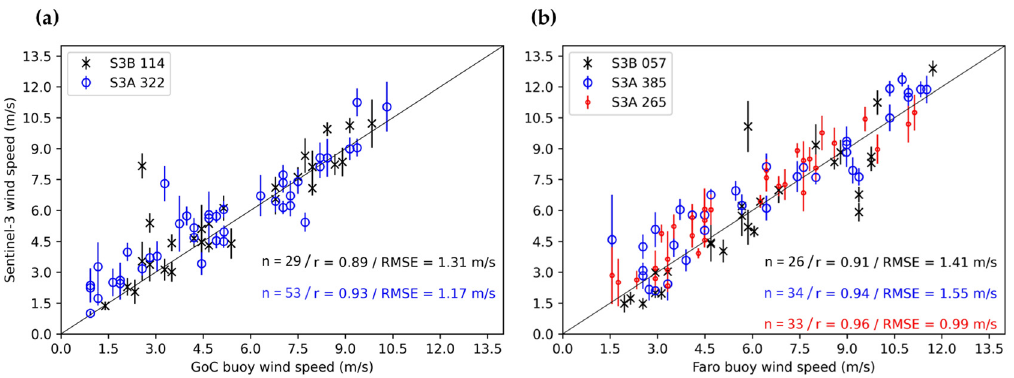
Figure 3. Scatterplot of the WS comparison among S3A ( a )/S3B ( b ) and in situ measurements from the GoC buoy. Vertical lines represent the standard deviation for each point based on the Sentinel-3 data inside the 25 km radius area (see Figure 1).